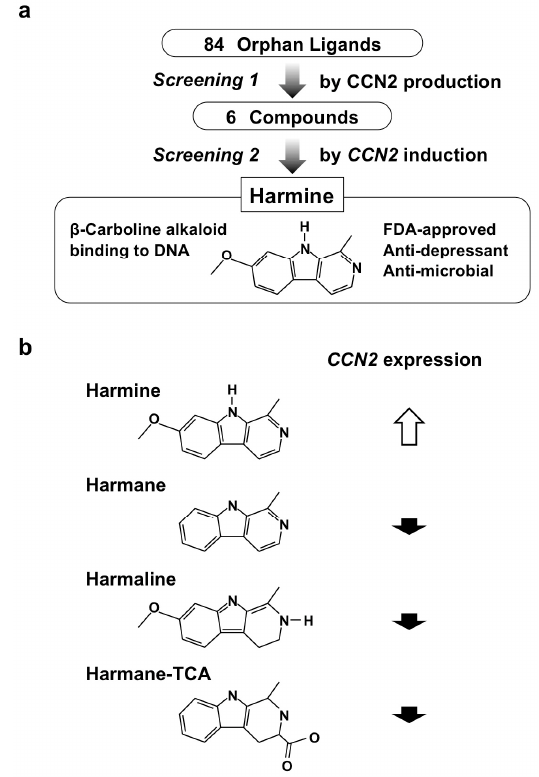
Figure 9. ( a ) Screening procedure employed for the re-discovery of harmine; ( b ) chemical structures and CCN2 inducing the activity of β -carboline alkaloids.